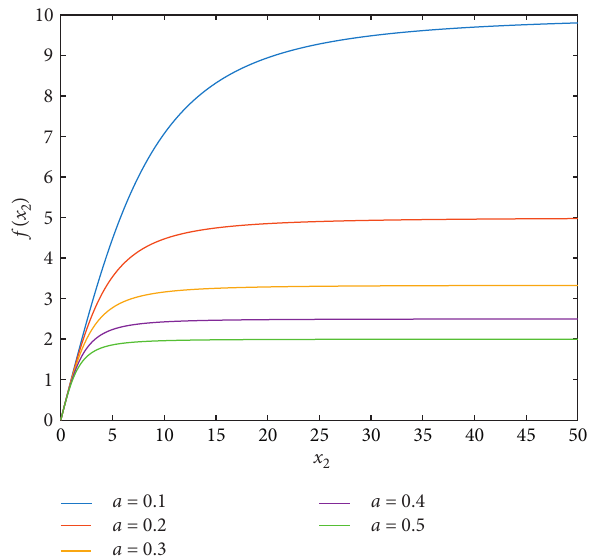
Figure 3: The graph of function f for different values of a